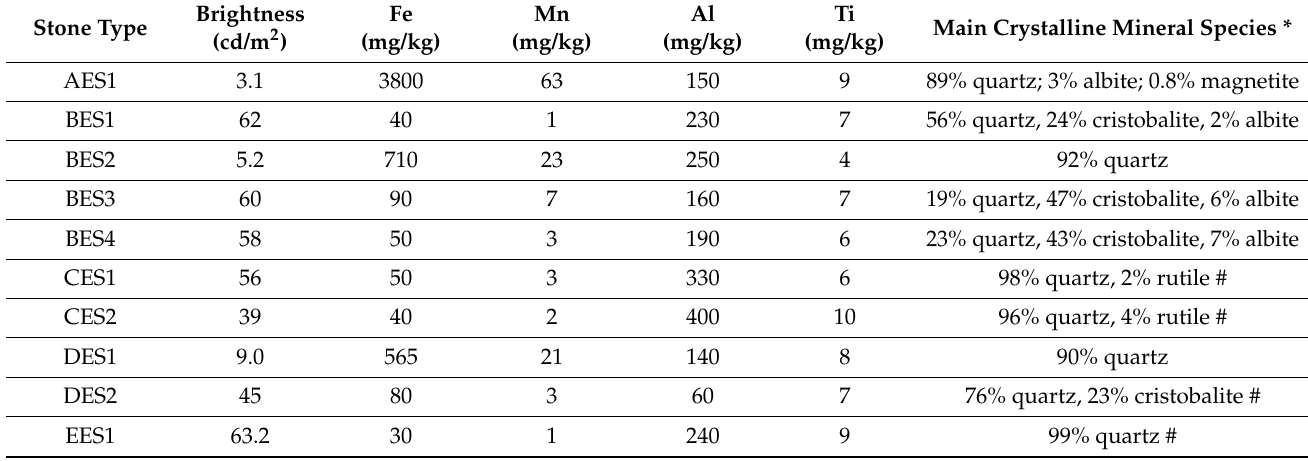
Table 1. Physico-chemical characteristics of stone types: Brightness of original ES samples, metal concentrations in dust and main crystalline species. Stone